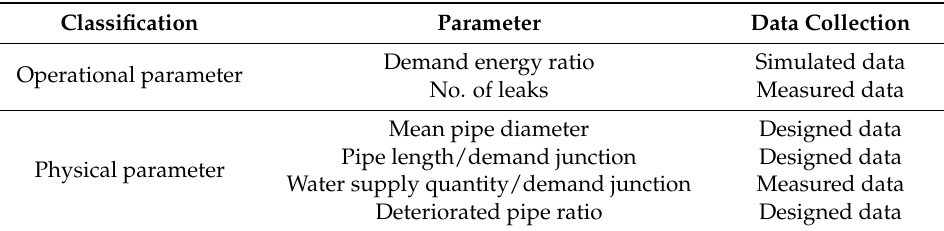
Table 3. Selected parameters for estimating NRW ratio.